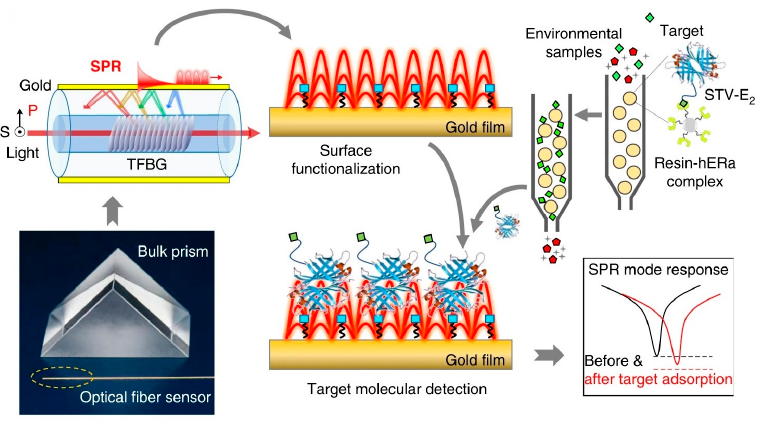
Figure 3. Plasmonic gold film-coated TFBG-based SPR biosensor for ultrasensitive estrogen (EE) detection. Reproduced from [34].